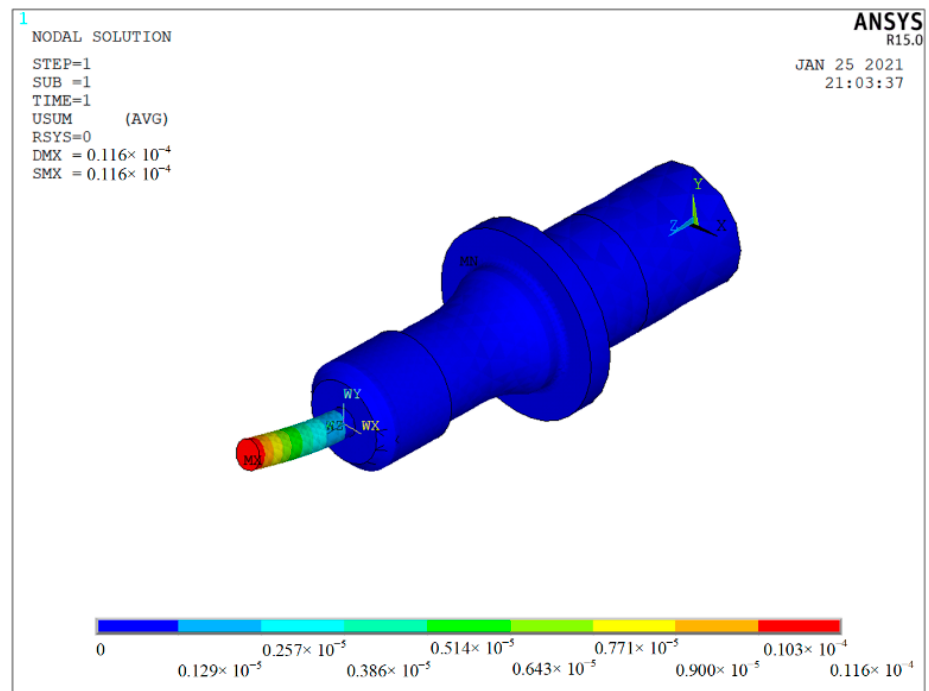
Figure 6. The cloud image of ultrasonic vibrator deflection.